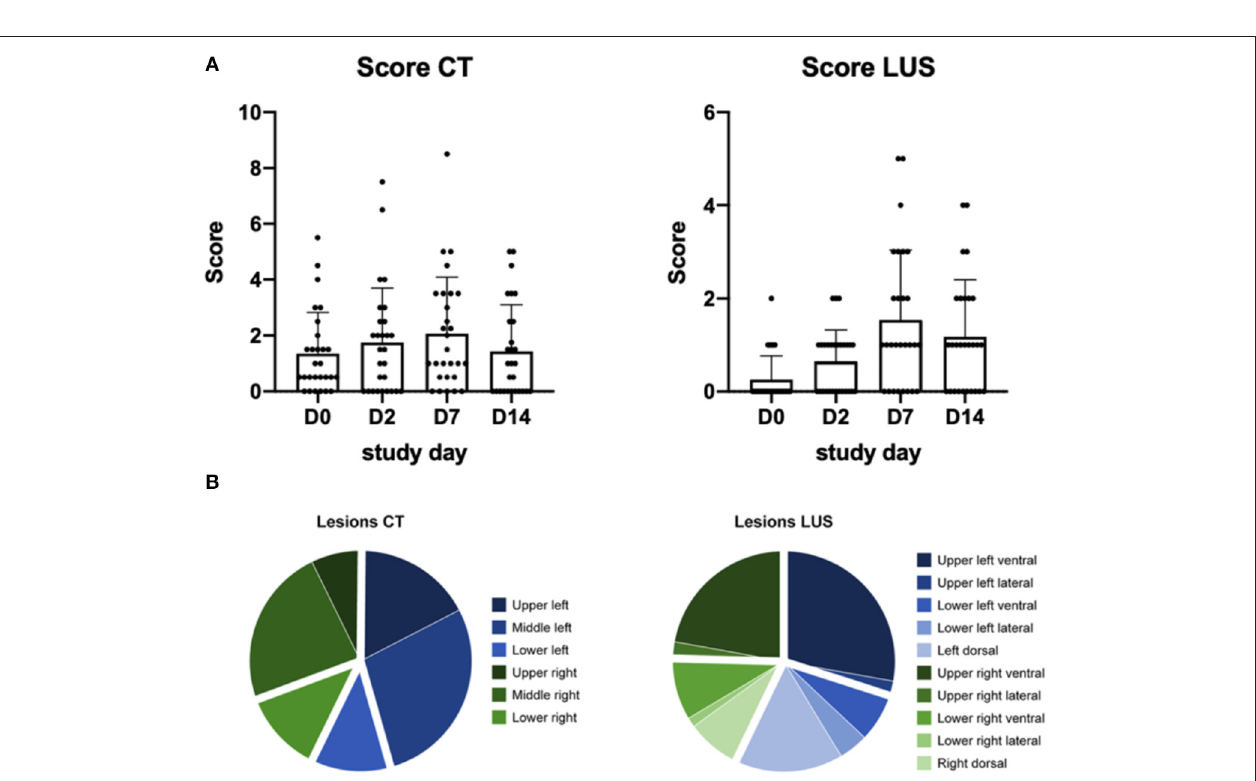
with a logit link was fitted with the function glmer of the package lme4 (16) in R version 3.5.2 (17). This